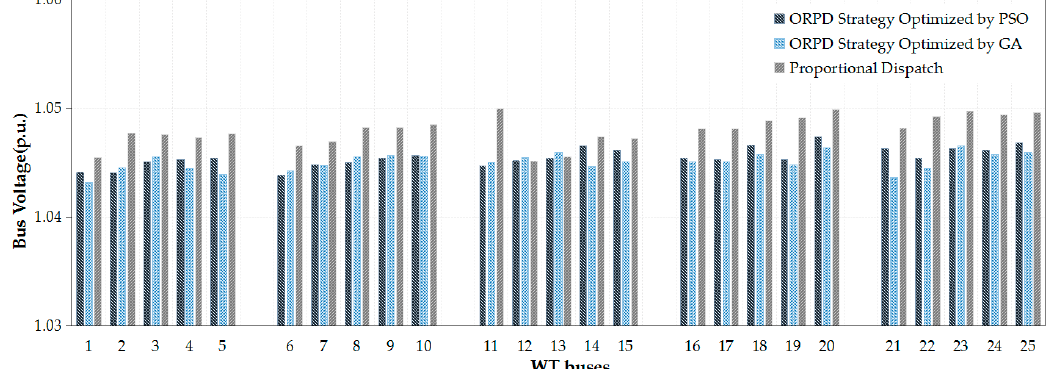
Figure 10. Wind turbine (WT) bus voltage when required reactive power references at PCC are set to 0.2 pu.